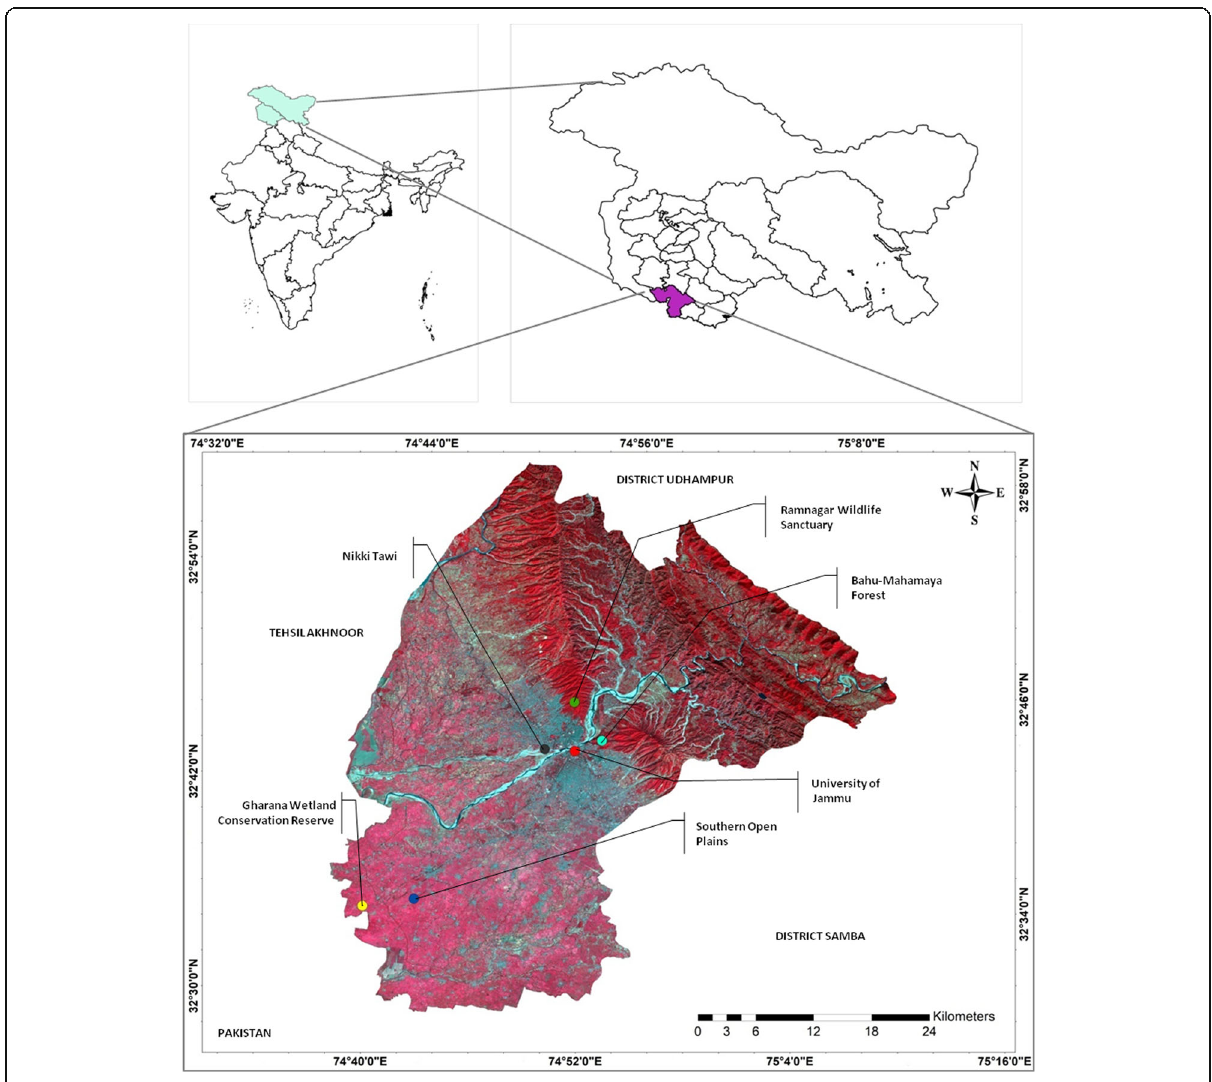
Fig. 1 Map of the study area showing sampling